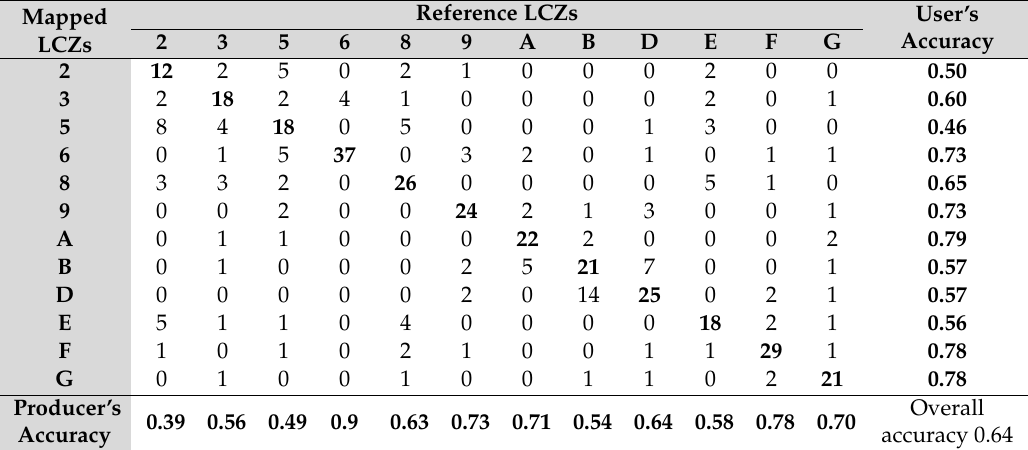
Table 3. Contingency matrix for LCZ classification accuracy assessment.